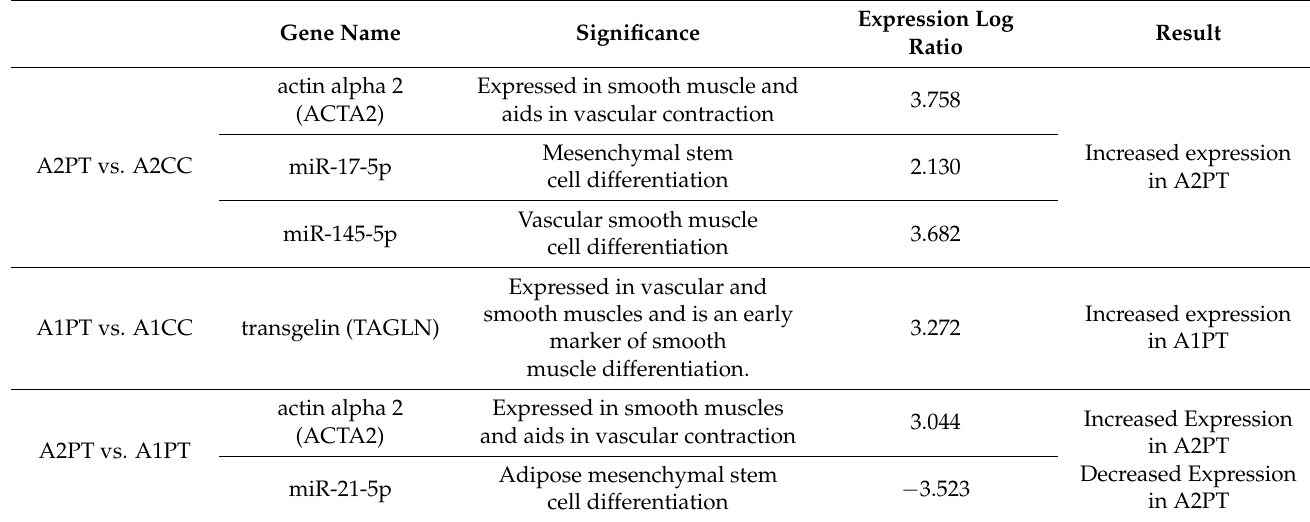
Table 3. RNA-Seq data analysis among different ADSC cell line/medium formulations. A comparison between different formulations showing the presence of smooth muscle-specific long-coding RNA (lncRNA) and micro RNA (miRNA) in PT treated samples, compared to samples cultured in CCM.